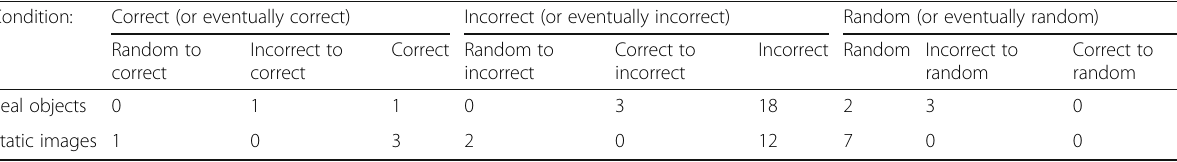
A binomial-probability test was carried out to classify a person ’ s performance on trials for which the faster object in a pair was small and light (see Appendix C for